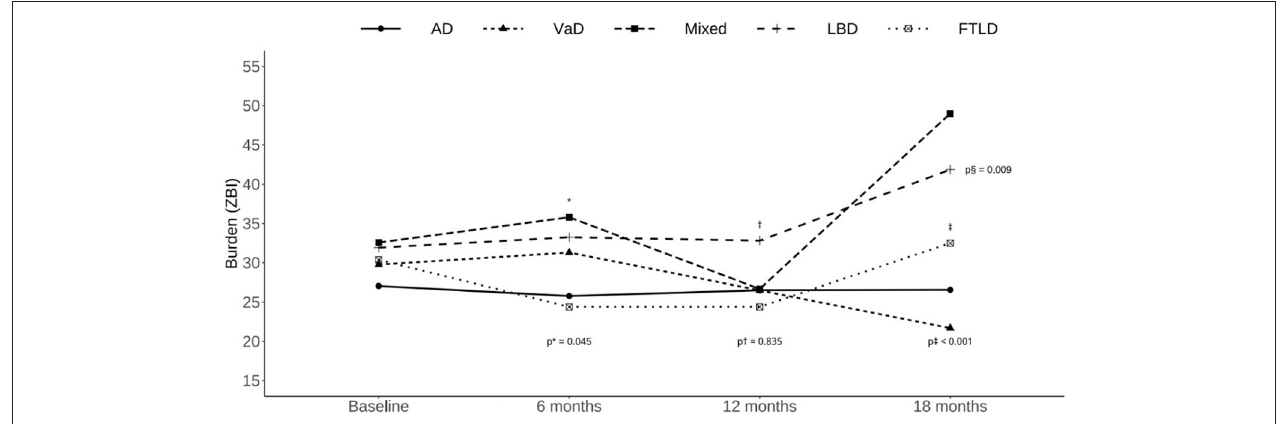
FIGURE 1 | The trajectory of Zarit Burden Interview scores in different dementia